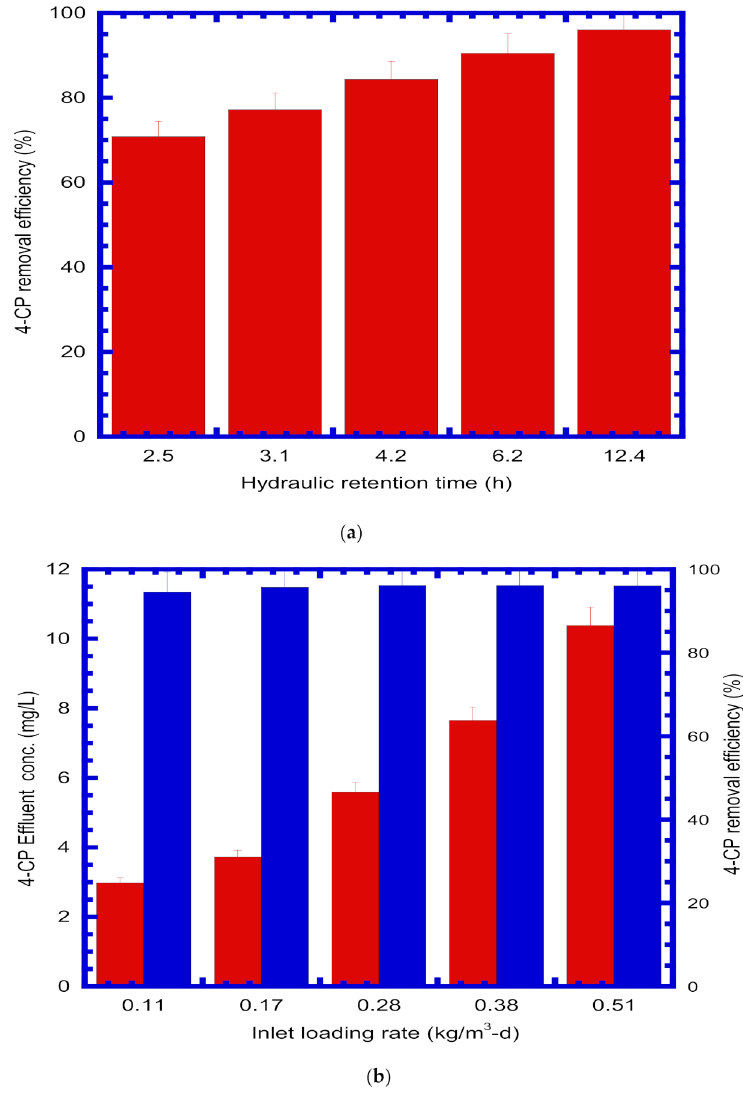
Figure 8. The effect of operation parameters on 4-CP removal efficiency at the steady state ( a ) hydraulic retention times ( b ) inlet loading